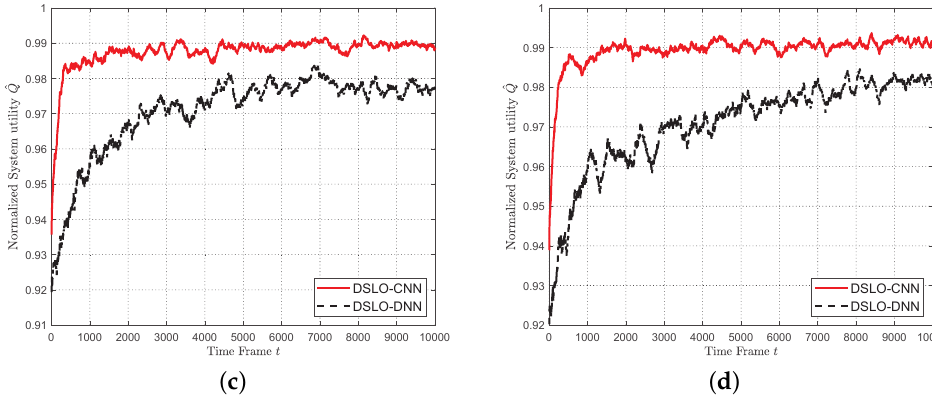
Figure 10. Convergence performance of DSLO under different scales of training MEC scenarios I train . ( a ) 10% I ]; ( b ) 30% I ; ( c ) 50% I ; ( d ) 70% I .